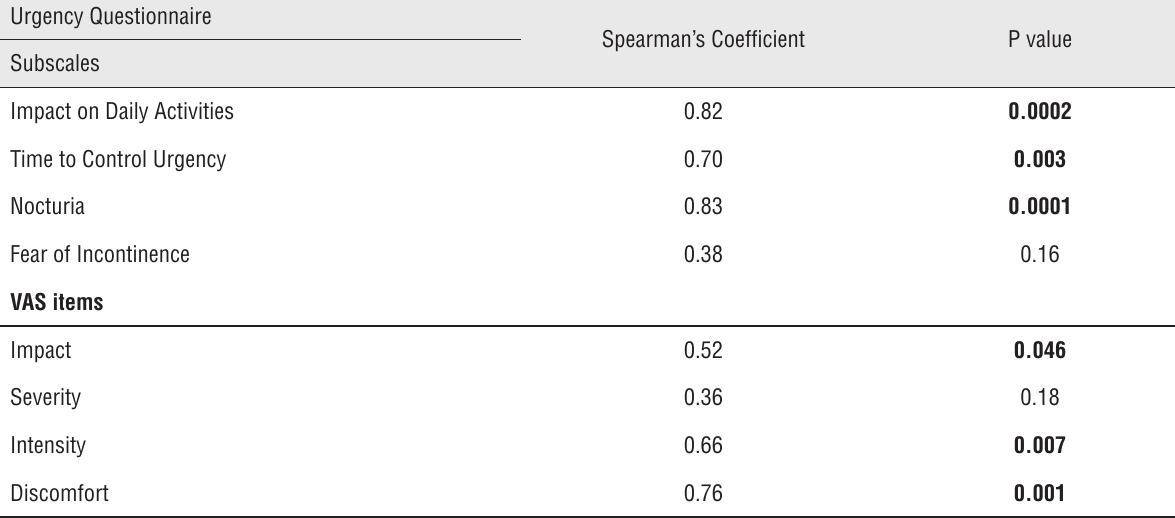
Table 4 - Correlation between the scores of the UQ subscales and vAS items at visit 1 and visit 2 (test–retest). Urgency